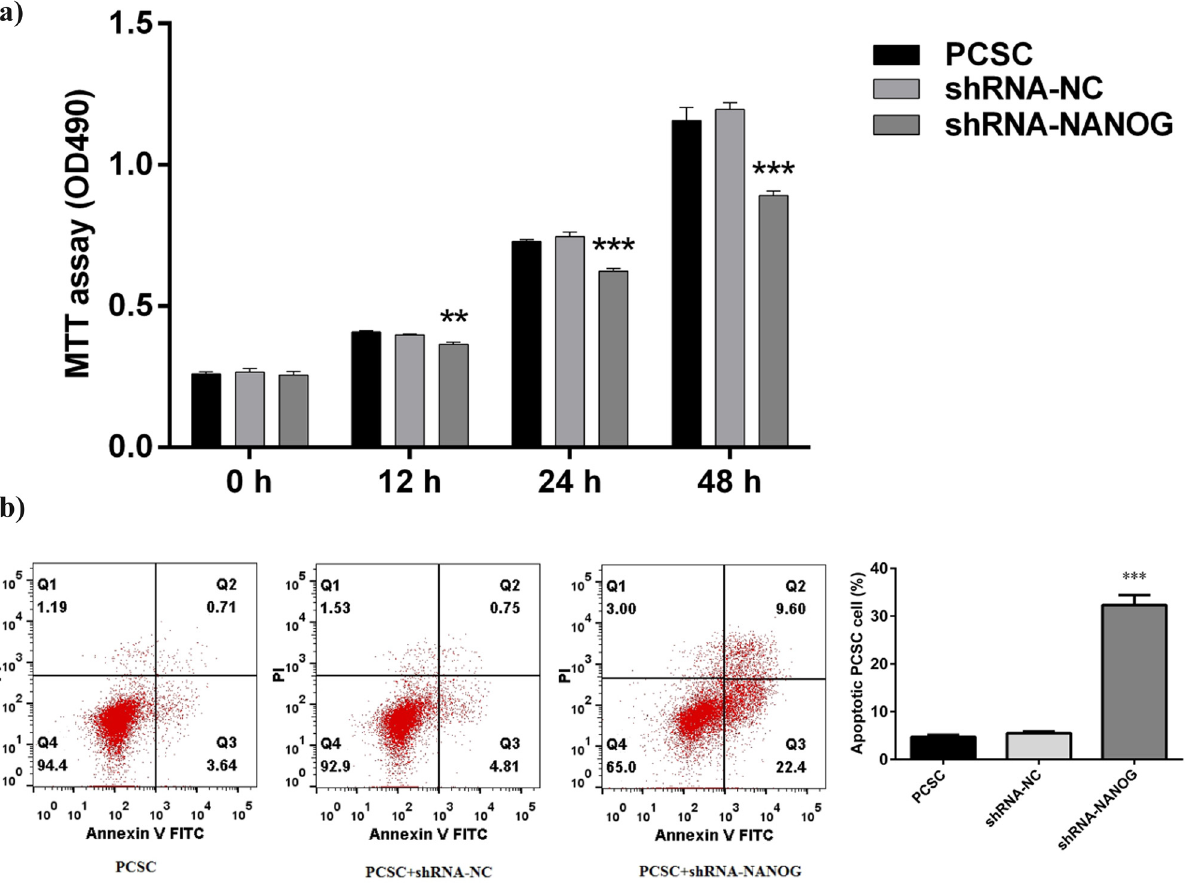
Figure 2: shRNA - NANOG inhibits PCSC proliferation and promotes PCSC apoptosis. ( a ) MTT assay was used to detect the proliferation of PCSC within 48 h of shRNA - NANOG transfection. After 12 h of shRNA - NANOG treatment, cell proliferation ability was signi fi cantly downregulated ( * p < 0.05, ** p < 0.01, and *** p < 0.001 ) , and the proliferation ability of cells was signi fi cantly inhibited after 24 and 48 h ( * p < 0.05, ** p < 0.01, and *** p < 0.001 ) . ( b and c ) Flow cytometry was used to detect apoptosis. shRNA - NANOG signi fi cantly promoted apoptosis of PCSCs ( * p < 0.05, ** p < 0.01, and *** p < 0.001 )